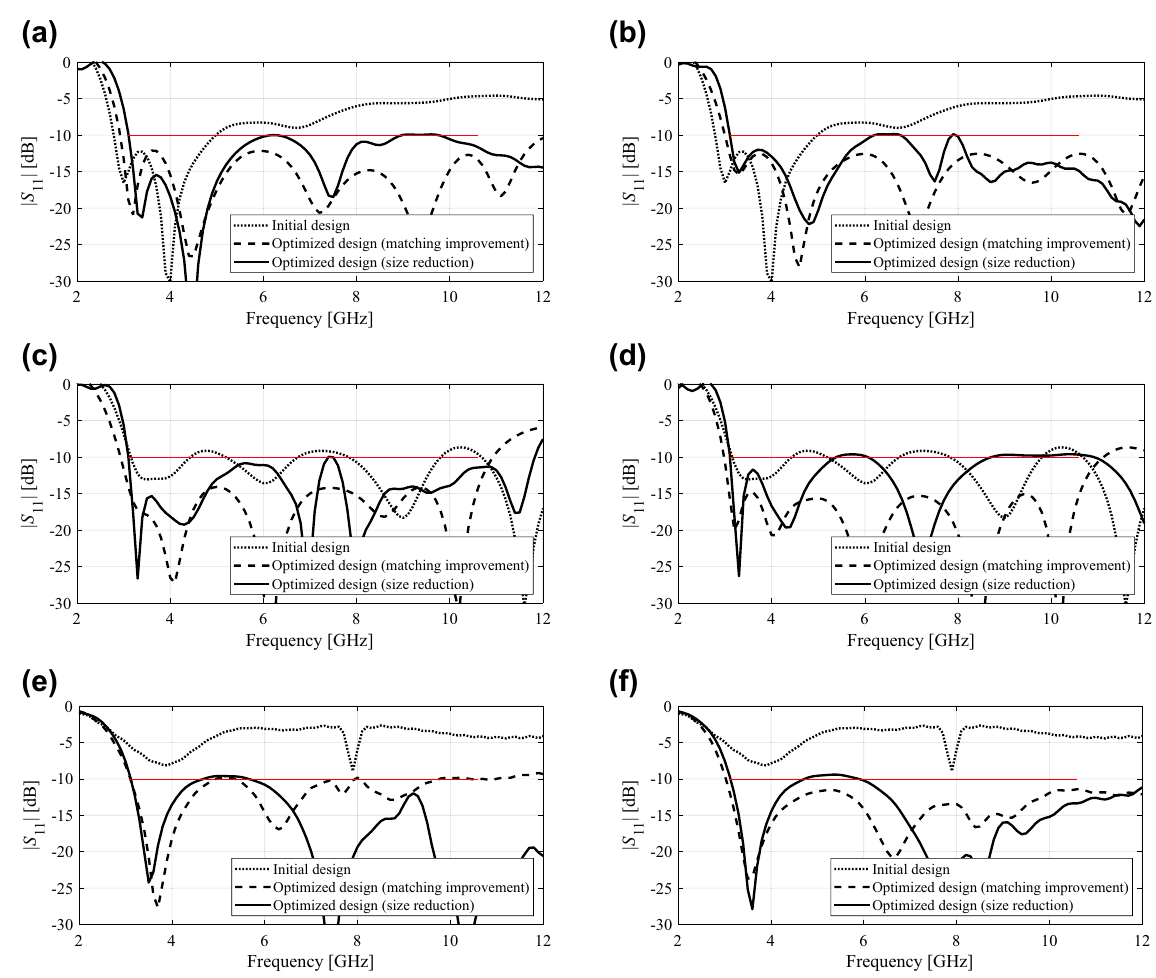
Figure 3. Selected optimization runs for Antennas I through III (see also Table 5): initial design ( ⋅⋅⋅⋅ ), design x *1 optimized for best matching, (- - -), design x *2 optimized for minimum size (—); Antenna I: (a) absolute parameterization ( S ( x *1 ) = − 12.4 dB, A ( x *2 ) = 278 mm 2 ), (b) relative parameterization ( S ( x *1 ) = − 12.2 dB, A ( x *2 ) = 300 mm 2 ); Antenna II: (c) absolute parameterization ( S ( x *1 ) = − 14.0 dB, A ( x *2 ) = 225 mm 2 ), (d) relative parameterization ( S ( x *1 ) = − 14.9 dB, A ( x *2 ) = 293 mm 2 ); Antenna III: (e) absolute parameterization ( S ( x *1 ) = − 10.0 dB, A ( x *2 ) = 201 mm 2 ), (f) relative parameterization ( S ( x *1 ) = − 11.4 dB, A ( x *2 ) = 229 mm 2 ). Design specifications for antenna reflection marked using a horizontal line. (Matlab R2016a https:// www. mathw orks.